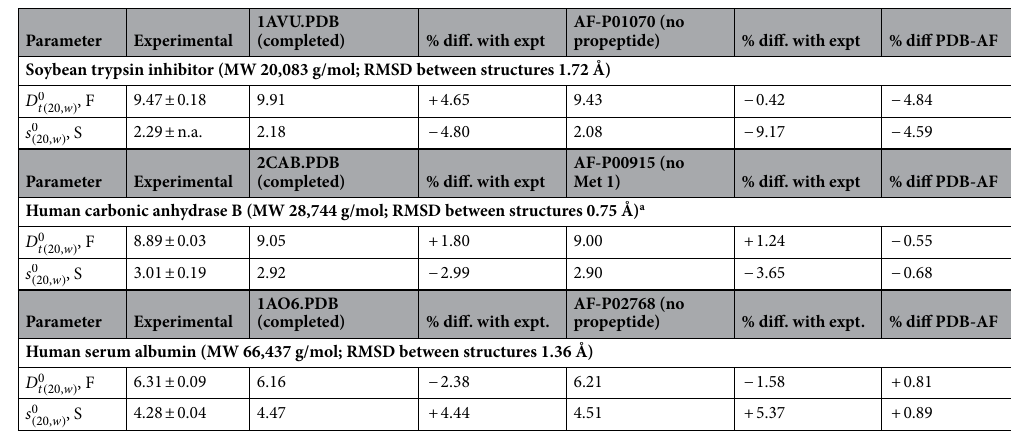
Table 1. Comparison between experimental and calculated D 0 t ( 20, w ) and s 0 ( 20, w ) for three proteins having a crystallographic structure and a predicted AF-v1 structure. The PDB entries had a few missing residues, which were previously manually added 21 ; the experimental parameters for all proteins were taken from Ref. 24 . a The 2CAB.PDB entry and the AF-P00915 structure differ at one amino acid position, and have also a position-swap on another two residues; the reported MW is that of the PDB